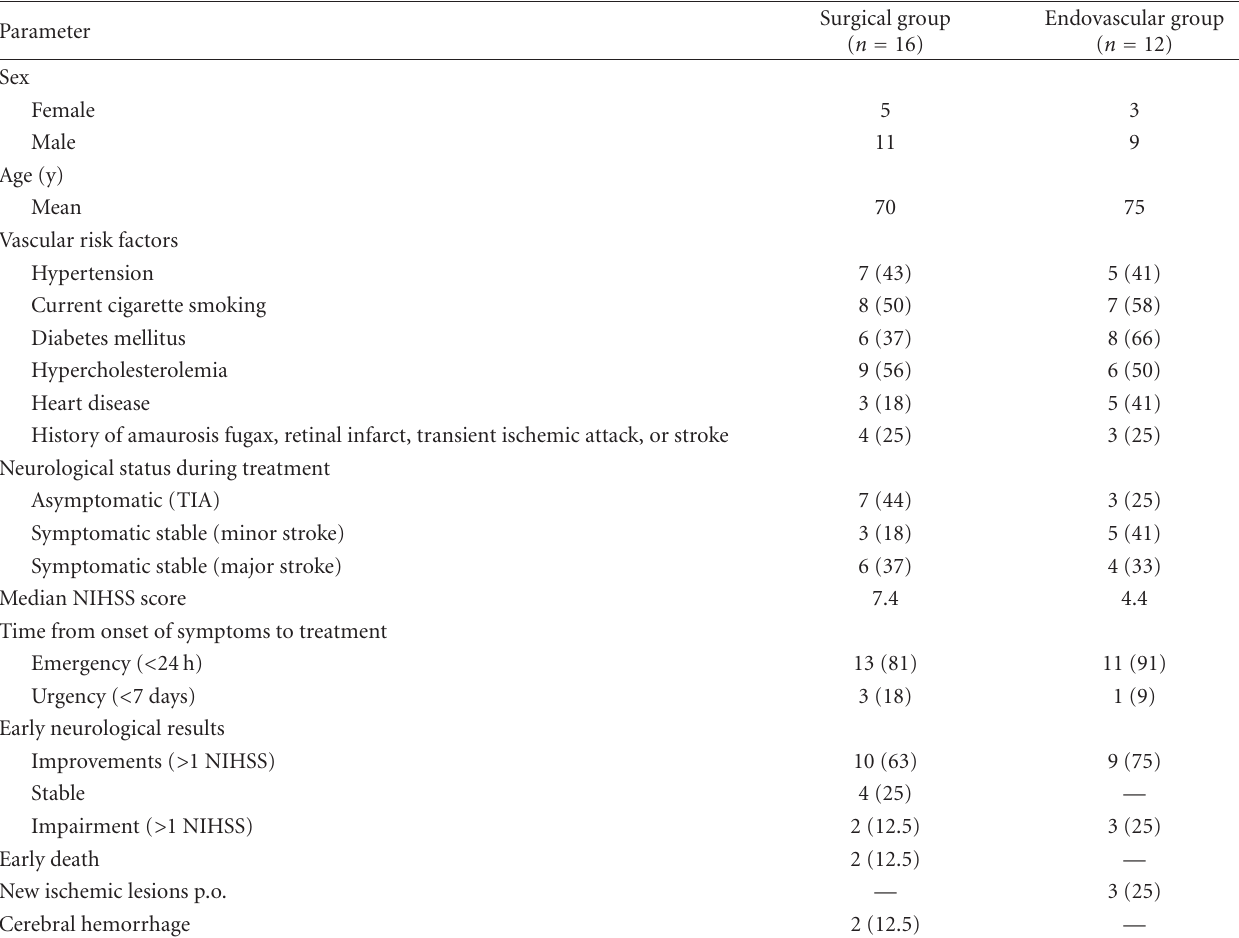
Table 1: Comparison of clinical characteristics and results of clinical workup between patients in surgical group and those in endovascular